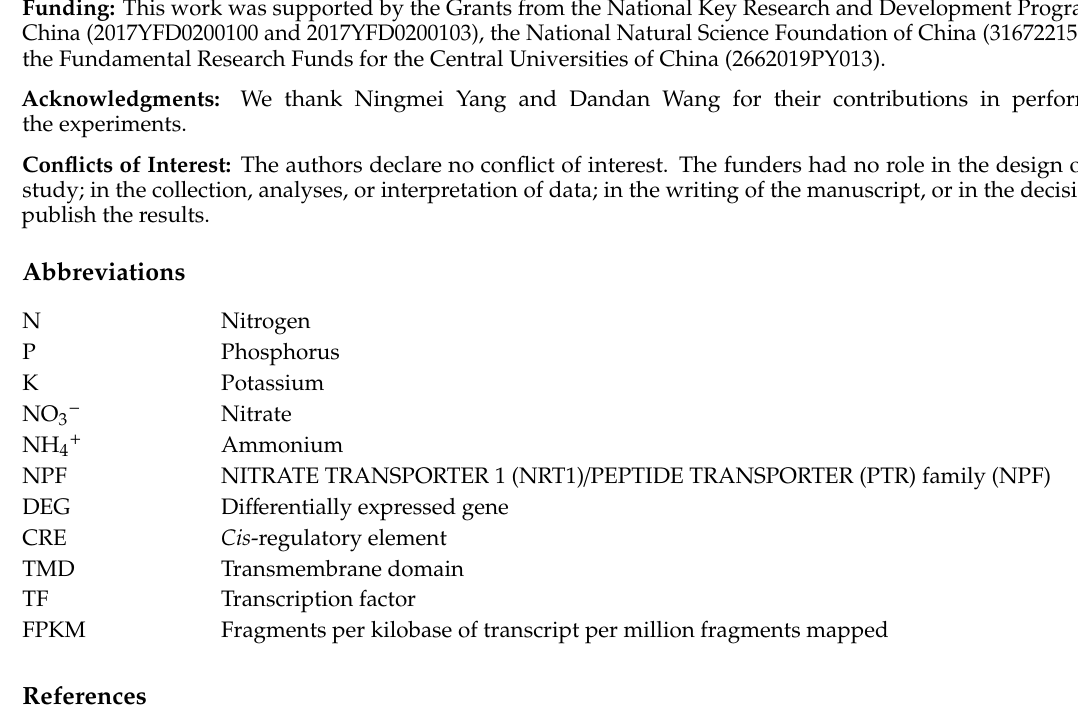
Figure S1: Gene structure of the NPF family in Arabidopsis and Brassica napus . Green boxes indicate UTR regions, yellow boxes indicate exons, and black lines indicate introns. Figure S2 : Conserved motifs of the NPF family protein in Arabidopsis and Brassica napus . ( A ) Motif characterization of BnaNPF proteins. The motifs, numbers 1-9, are displayed in di ff erent colored boxes. ( B ) the sequence information for each motif. Figure S3 : Chromosomal locations of NPF family in Brassica napus . The 193 BnaNPF genes were mapped to the 19 chromosomes of B. napus based on the exact chromosomal information available in the database. The red fonts indicate the position of the corresponding BnaNPF genes on each chromosome. The diagram was drawn using the Mapchart software. Bar = 10 Mb. Figure S4 : Transmembrane domain analysis of the 10 core NPF genes in Brassica napus . The diagram was drawn based the full-length of the core BnaNPF protein sequences using the TMHMM program. The red regions or boxes indicate the transmembrane domains. Table S1 : Primers used for quantitative real-time PCR used in this study. Table S2 : Characteristics of the NPF family members in Brassica napus and subcellular localization prediction. Table S3 : Non-synonymous (Ka) and synonymous (Ks) nucleotide substitution rates for NPF coding loci in Arabidopsis and Brassica napus . Table S4 : FPKM of the NPF family in leaves and roots of Brassica napus under nitrogen, phosphorus, potassium stresses and ammonium